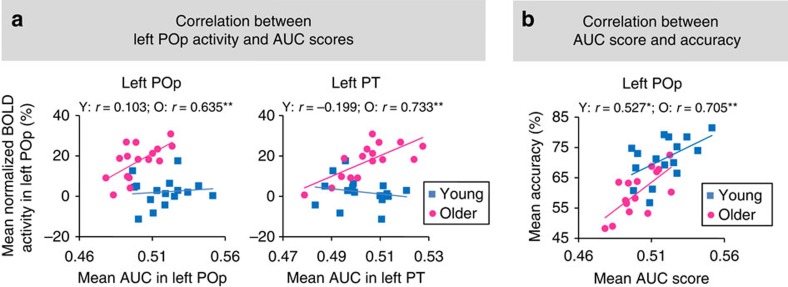
Relationships between frontal activity and phoneme specificity and behavioral accuracy.(a) The mean activity across −12 to 8 dB SNRs in the POp spherical ROI (−50, 14, 18; 8-mm radius) positively correlated with the mean AUC score across those SNRs in the left POp and left PT in older adults (open circles) but not in young adults (filled squares). (b) The mean AUC score across −12 to 8 dB SNRs in the left POp positively correlated with the mean accuracy at those SNRs in both age groups. *P<0.05; **P<0.01 by Pearson's correlations.